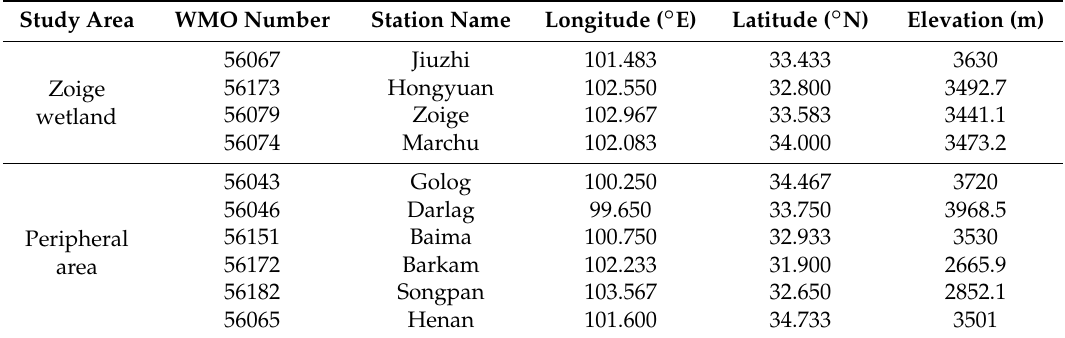
Table 1. List of meteorological stations in the Zoige wetland and its peripheral areas with WMO number, station name, longitude, latitude, and elevation.